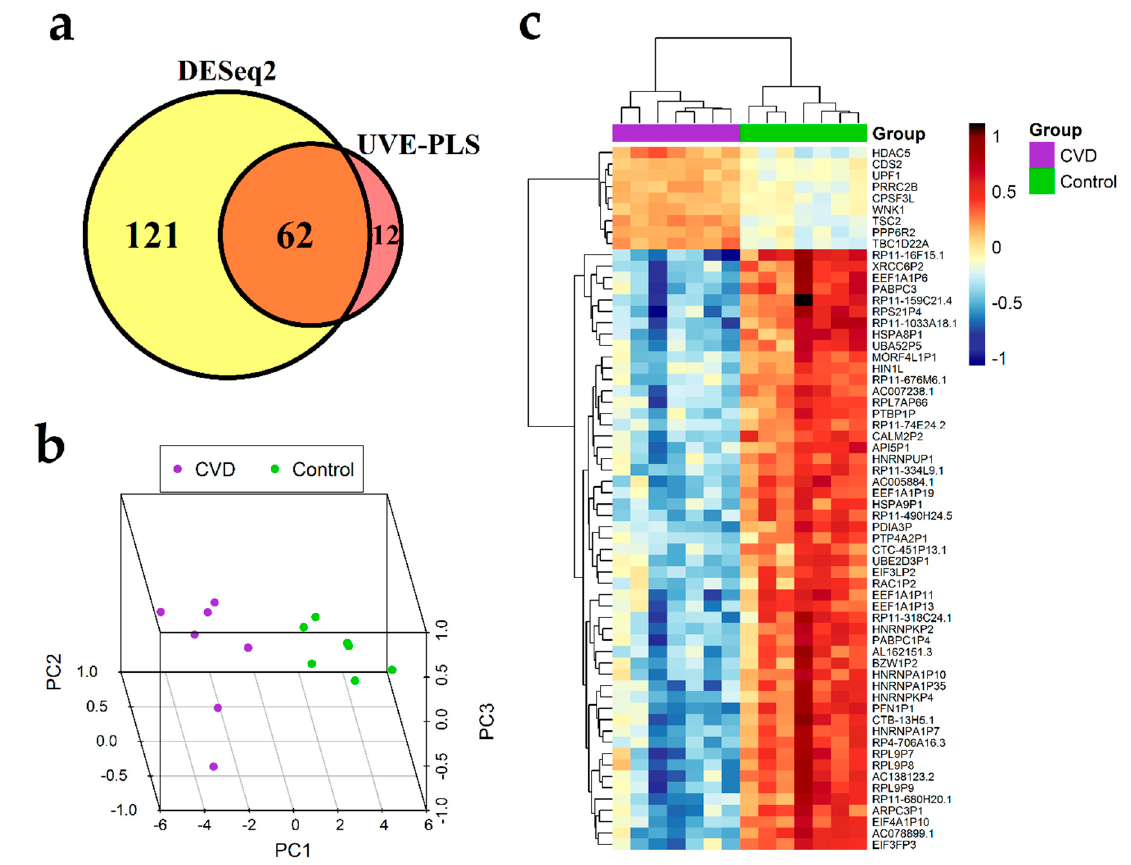
Figure 3. Results of di ff erential expression analysis of genes in group of seven patients with chronic venous disease (CVD) vs. seven healthy controls group (Control). ( a ) Venn diagram presenting comparison of two gene sets: the set of 183 genes received from DESeq2 analysis with p < 0.00001 and the set of 74 informative genes indicated by Uninformative Variable Elimination by Partial Least Squares (UVE-PLS) analysis. Sixty-two genes were common for both sets of genes. 3D Principal Component Analysis (PCA) plot ( b ) and heatmap with Euclidean clustering ( c ) show di ff erential expression of common 62 genes in CVD and Control